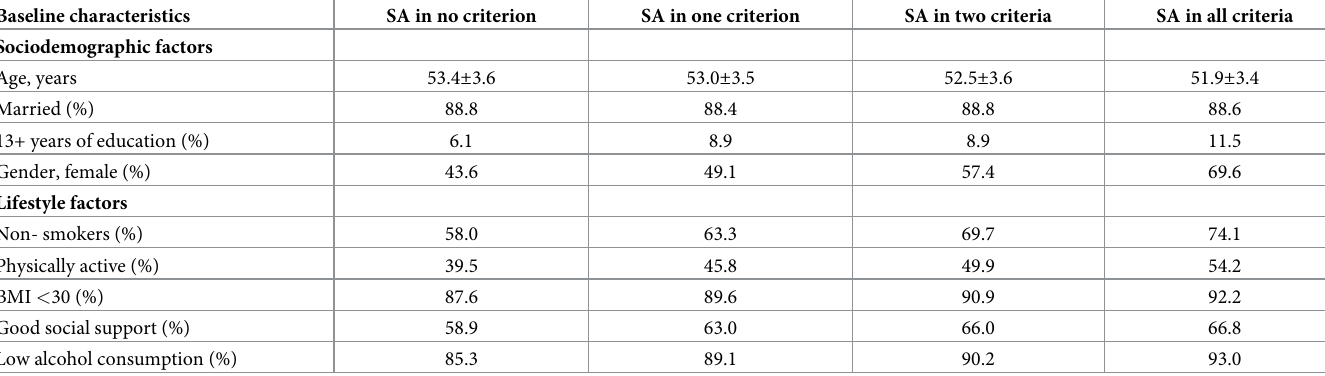
Table 2. Comparison of baseline characteristics between participants with different levels of successful aging. Baseline